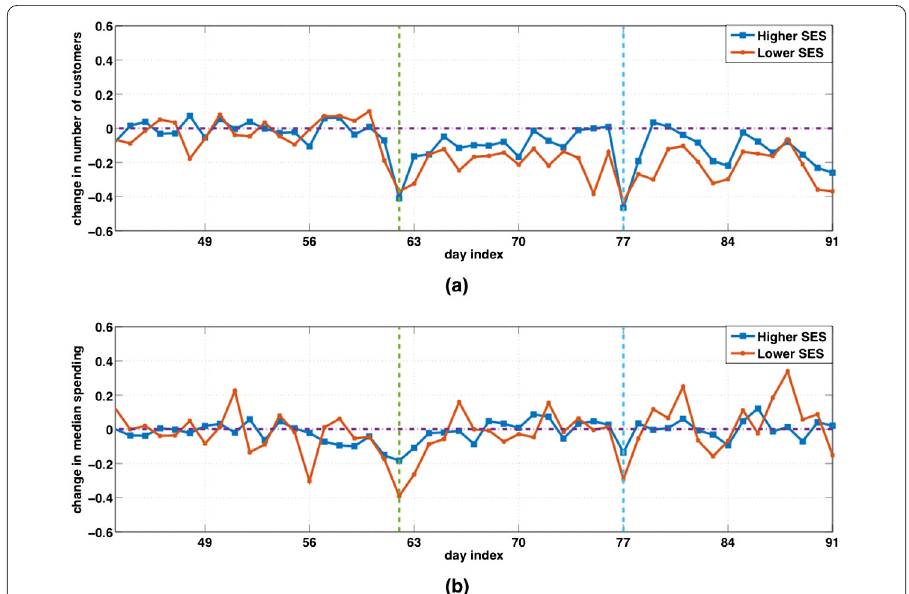
Figure 6 The impact of a series of protest events in neighborhoods of higher socio-economic status (blue) and lower socio-economic status (red): ( a ) number of customers; ( b ) median spending. The dash-dot purple line indicates zero change, and the dashed green and cyan lines indicate Day 62 and Day 77, respectively